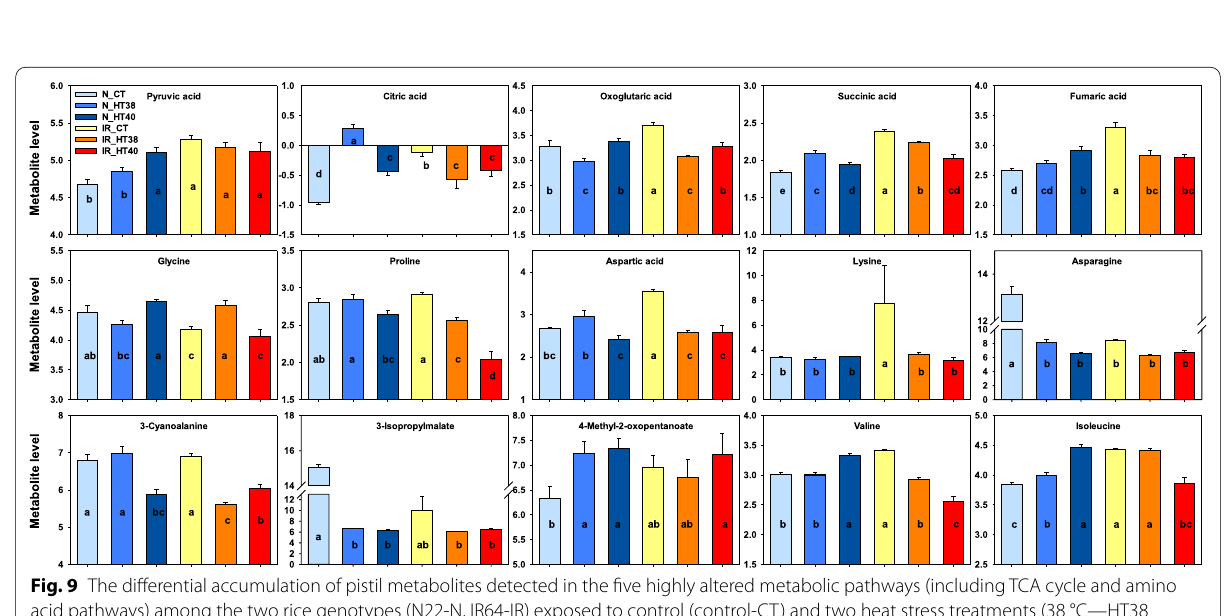
Fig. 9 The differential accumulation of pistil metabolites detected in the five highly altered metabolic pathways (including TCA cycle and amino acid pathways) among the two rice genotypes (N22‑N, IR64‑IR) exposed to control (control‑CT) and two heat stress treatments (38 °C—HT38 and 40 °C—HT40) at six days after temperature treatment (6DAT). Bars represent Log2 fold change of the normalized values averaged across replications, bars indicate SE (n 6). Different alphabets indicate significant difference between temperature treatments and genotypes for a = metabolite at 5%